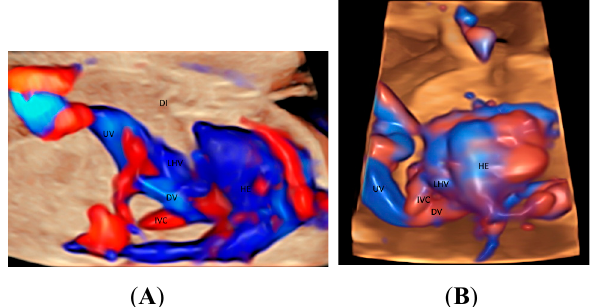
Figure 3. Glass-body rendering mode with high-definition Doppler showing a normal fetus ( A ), and a fetus with left diaphragmatic hernia with ‘liver up’ ( B ), both at 21 weeks’ gestation. Note the difference in the position of the left hepatic vein (LHV) draining into the right atrium (RA) between ( A , B ). DI, diaphragm; Ductus venosus (DV); HE, heart; IVC, inferior vena cava; UV, umbilical vein.